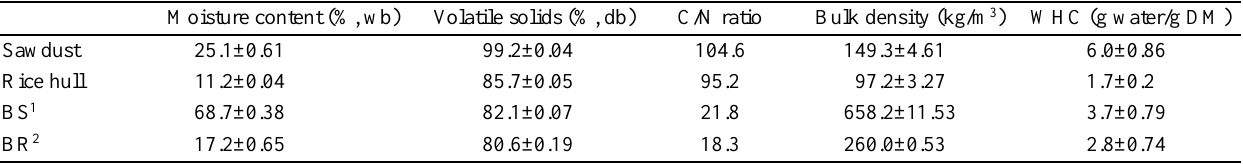
Table 1. General characteristics of bedding and beef manure mixtures Moisture content (%,